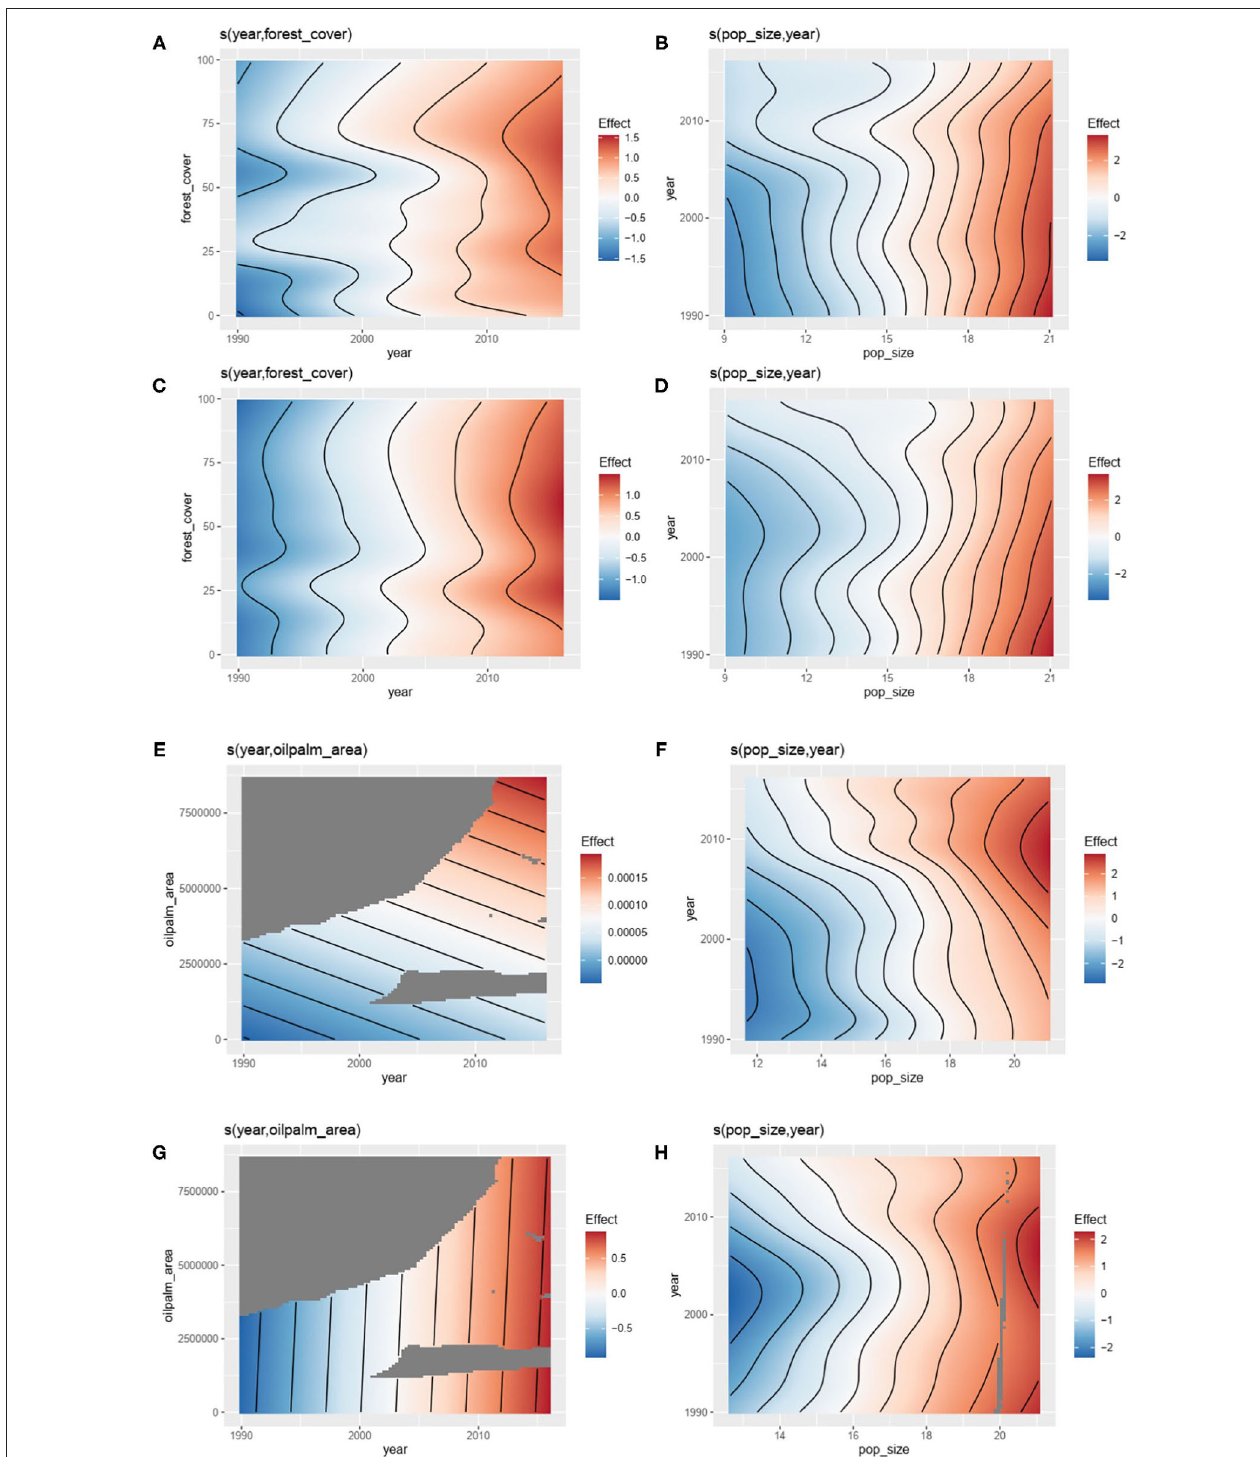
FIGURE 3 | Results of General additive modeling (GAM) explaining: the number the number of outbreaks of zoonotic diseases with (A) forest cover (controlling for year) and (B) human population size (controlling for year) (see Table 1 , model 1); the number the number of outbreaks of vector-borne diseases with (C) forest cover (controlling for year) and (D) human population size (controlling for year) (see Table 1 , model 2); the number the number of outbreaks of zoonotic diseases with (E) oil palm area (controlling for year) and (F) human population size (controlling for year) (see Table 1 , model 3); the number the number of outbreaks of vector-borne diseases with (G) oil palm area (controlling for year) and (H) human population size (controlling for year) (see Table 1 , model 4) (data from GIDEON, FAOSTAT and World Bank).